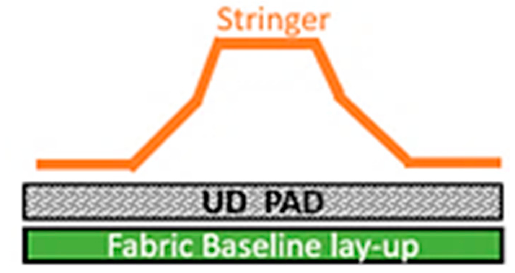
Figure 6. Stringer optimization scheme .